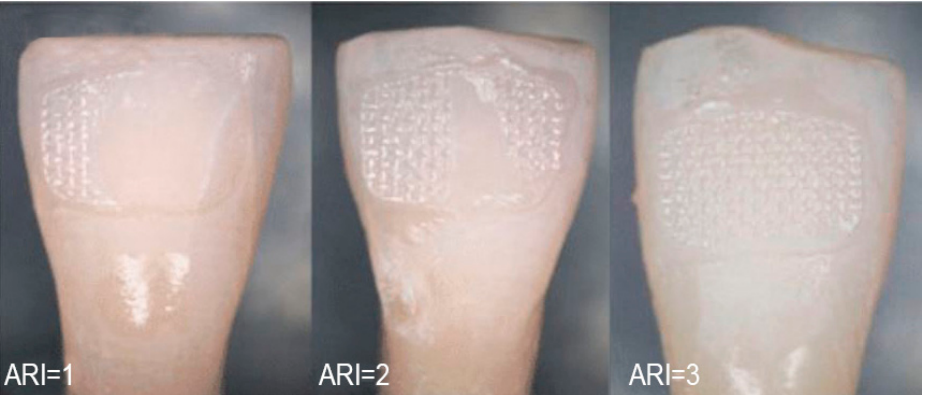
Figure 5. Illustration of Adhesive Remnant Index (ARI): ARI 0, no adhesive on the tooth; ARI 1, less than 1/2 adhesive on the tooth; ARI 2, more than 1/2 of the adhesive on the tooth; ARI 3, all of the adhesive on the tooth.